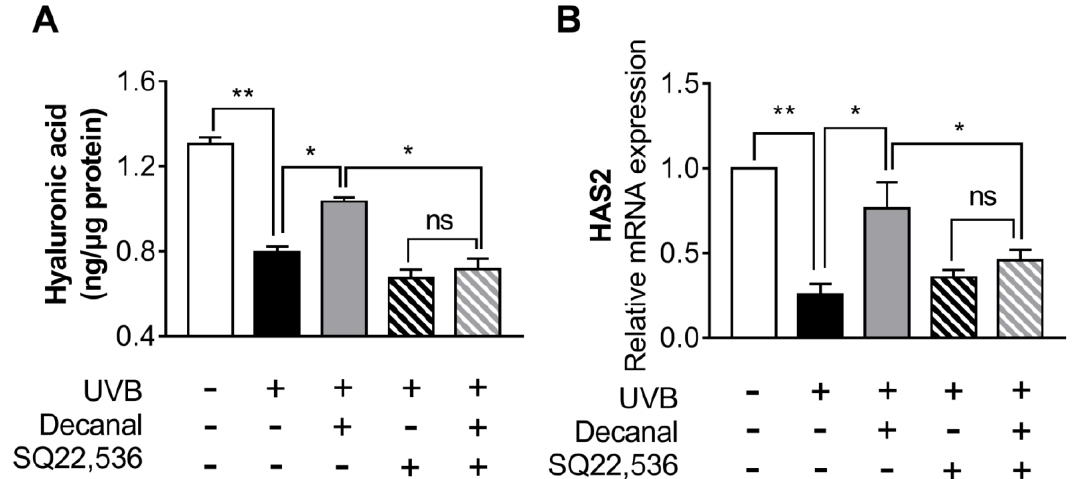
Figure 6 . The effect of decanal on hyaluronic acid synthesis via the cAMP signaling pathway. Hs68 cells were treated with either decanal or the vehicle and exposed to UVB. Other samples were pretreated with either SQ22536 or the vehicle for 1 h before decanal treatment. ( A ) Hyaluronic acid concentrations and ( B ) the mRNA expression of HAS2 were examined. The final hyaluronic acid levels were normalized to the total cellular protein content. Data are shown as the mean ±SEM ( n = 3). Significant differences are indicated as * p < 0.05; ** p < 0.01.